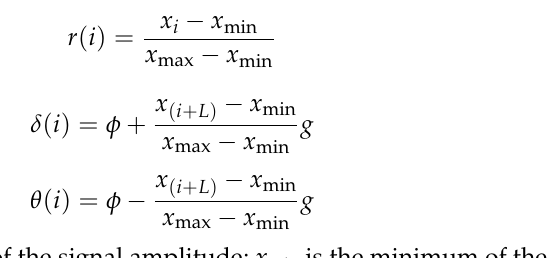
Figure 3. Gray-level co-occurrence matrix generation directions.